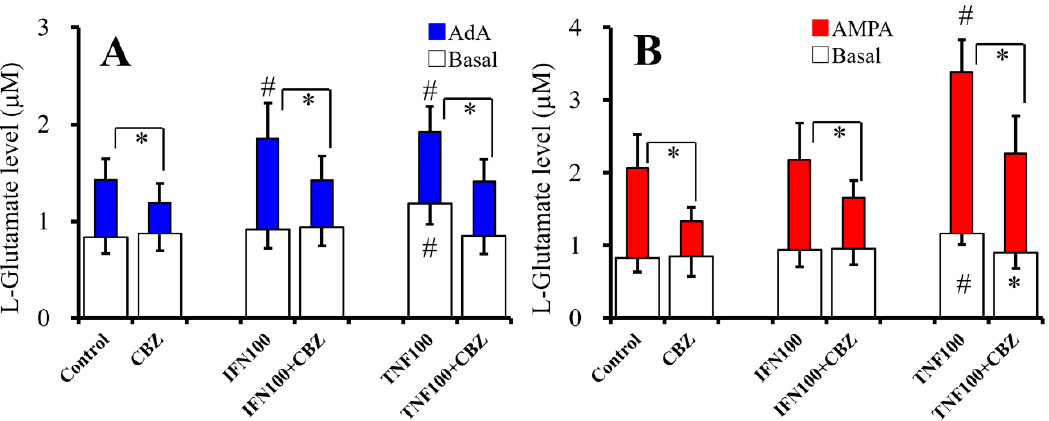
Figure 6. Interaction between chronic administration of cytokines and CBZ on basal, AdA-, and AMPA-evoked L-glutamate releases. E ff ects of chronic administration of IFN γ (100 IU / mL), TNF α (100 IU / mL), and CBZ (20 µ M) on basal (opened) and 1 µ M AdA-evoked ( A , blue) L-glutamate release are indicated in Figure 6A. E ff ects of chronic administration of IFN γ (100 IU / mL), TNF α (100 IU / mL) with CBZ (20 µ M) on basal (opened), and 100 µ M AMPA-evoked ( B , red) L-glutamate release are indicated in Figure 6B. Ordinates indicate mean levels of L-glutamate ( µ M) ( N = 6). * p < 0.05 relative to